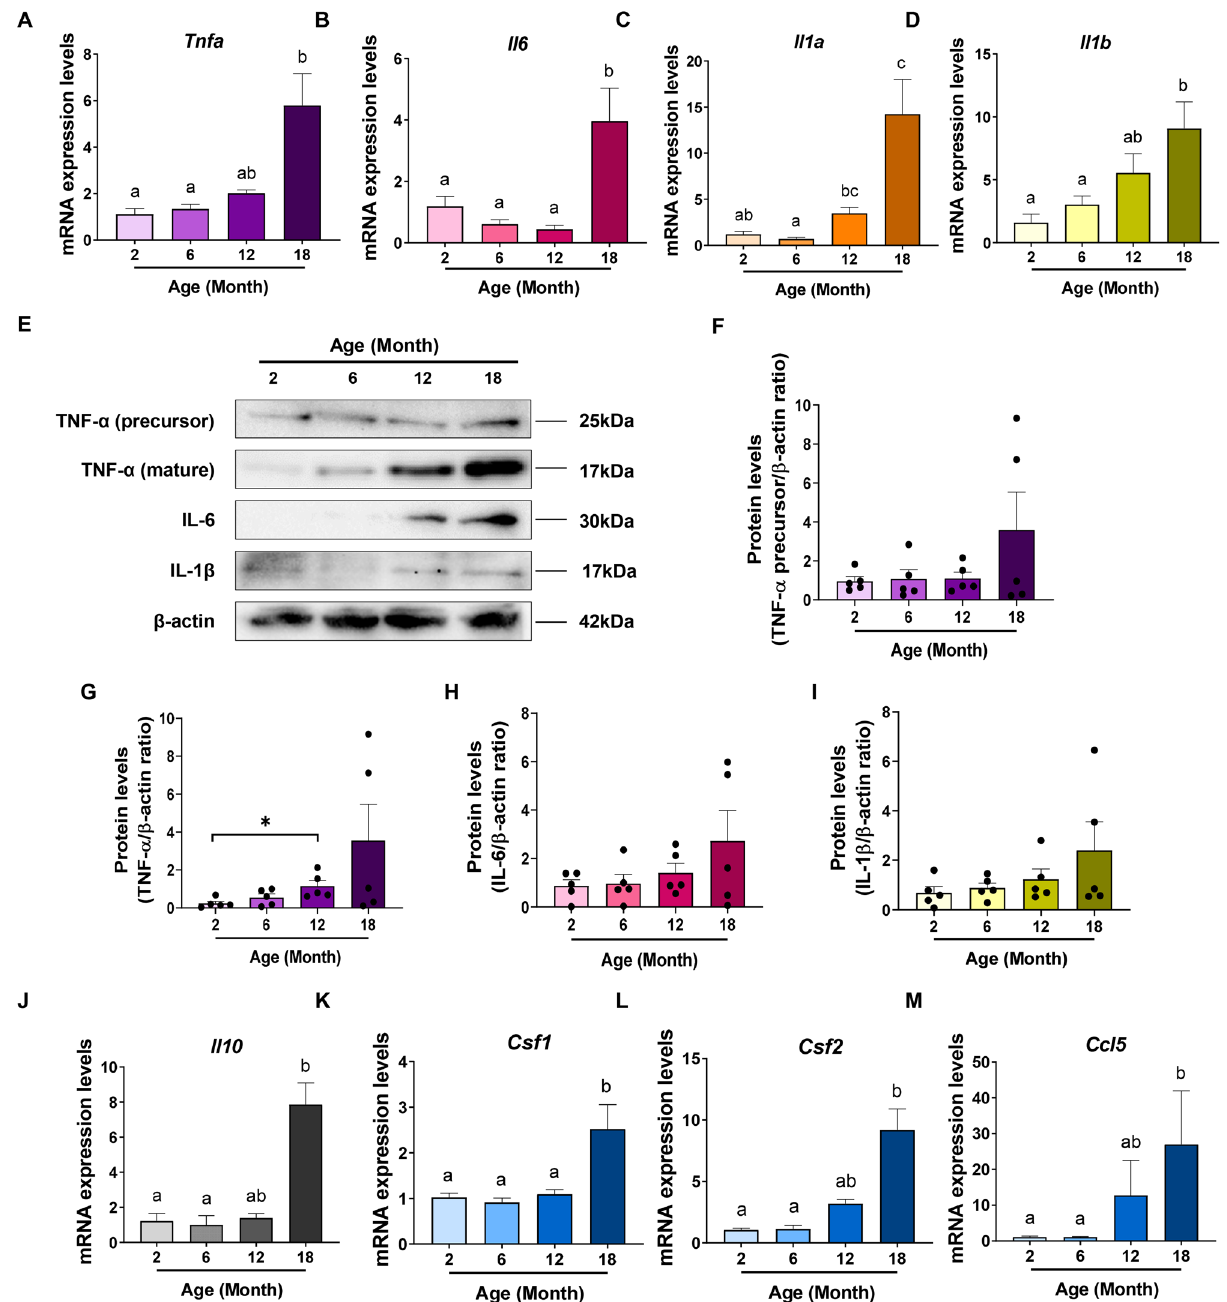
Figure 3. Reproductive ageing is associated with a local inflammatory microenvironment in the mouse ovary. Gene expression levels of Tnfa ( A ), Il6 ( B ), Il1a ( C ) and Il1b ( D ) in ovaries from 2, 6, 12 and 18-month-old mice. n = 6 per cohort. Data are presented as mean ± SEM; ( A ) and ( C ): Kruskal–Wallis test, Dunn’s multiple comparisons test: a, b and c are significantly different among groups ( p < 0.05); ( B ) and ( D ): Ordinary One-way ANOVA, Tukey’s multiple comparisons test: a and b are significantly different among groups ( p < 0.05). ( E ) Representative image of a Western blot showing ovarian protein levels of TNF-α (precursor), TNF-α (mature), IL-6 and IL-1β from 2, 6, 12 and 18-month-old mice. Quantification of protein levels of TNF-α (precursor) ( F ), TNF-α (mature) ( G ), IL-6 ( H ) and IL-1β (I) in ovaries from 2, 6, 12 and 18-month-old mice. n = 5 per cohort. Data are presented as mean ± SEM; Mann–Whitney test (* p < 0.05). Each dot represents one animal. mRNA levels of Csf1 ( J ), Csf2 ( K ), Ccl5 ( L ) and Il10 ( M ) in ovaries from 2, 6, 12 and 18-month-old mice. n = 6 per cohort. Data are presented as mean ± SEM; I: Ordinary One-way ANOVA, Tukey’s multiple comparisons test: a and b are significantly different among groups ( p < 0.05); ( J ), K , L ): Kruskal–Wallis test, Dunn’s multiple comparisons test: a, and b are significantly different among groups ( p <